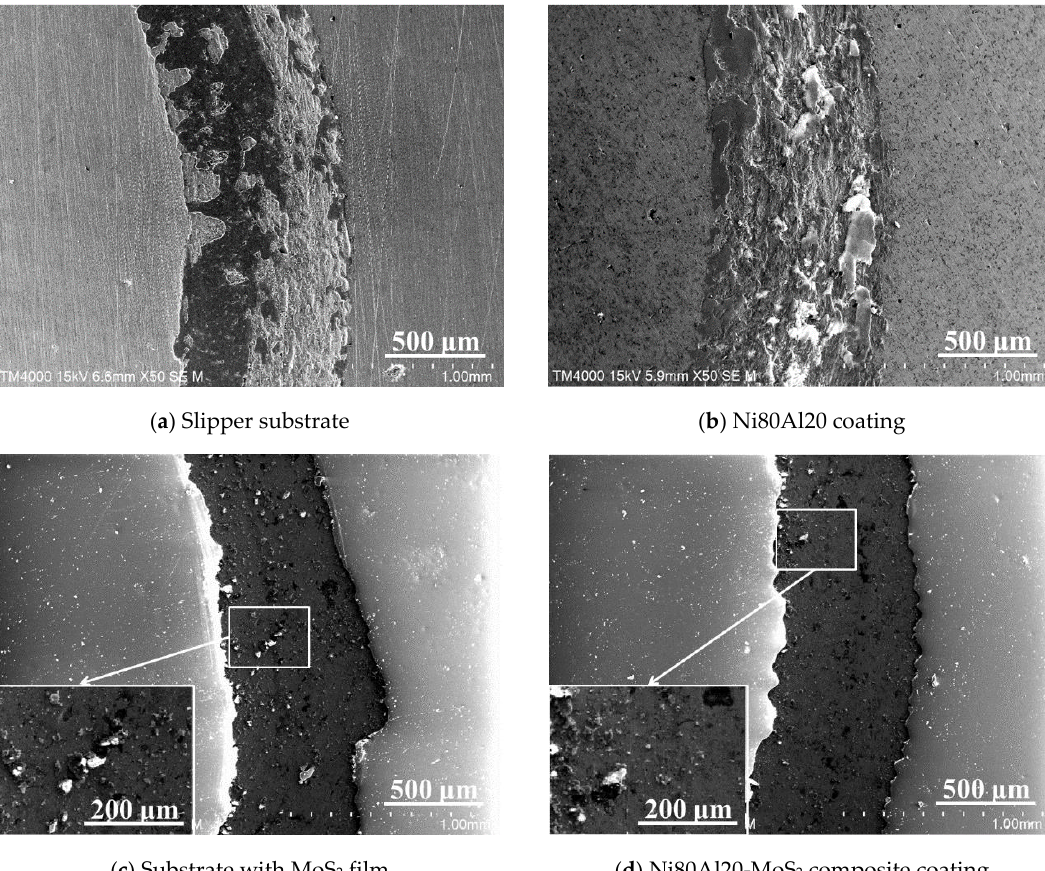
Figure 10. Micromorphology of wear scars on samples rubbing with GCr15 ball, ( a ) Slipper substrate, ( b ) Ni80Al20 coating, ( c ) Substrate with MoS 2 film and ( d ) Ni80Al20-MoS 2 composite coating.